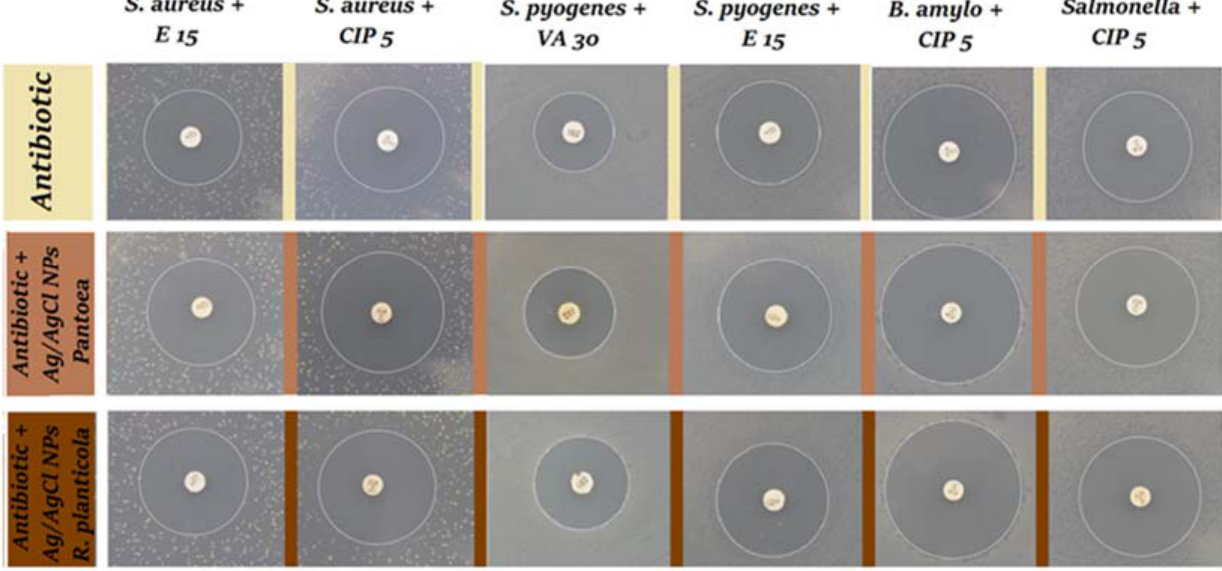
Figure 8. Images of the inhibition zone of Staphylococcus aureus , Streptococcus pyogenes , Salmonella , and Bacillus amyloliquefaciens in the presence of erythromycin, ciprofloxacin, and vancomycin, respectively .